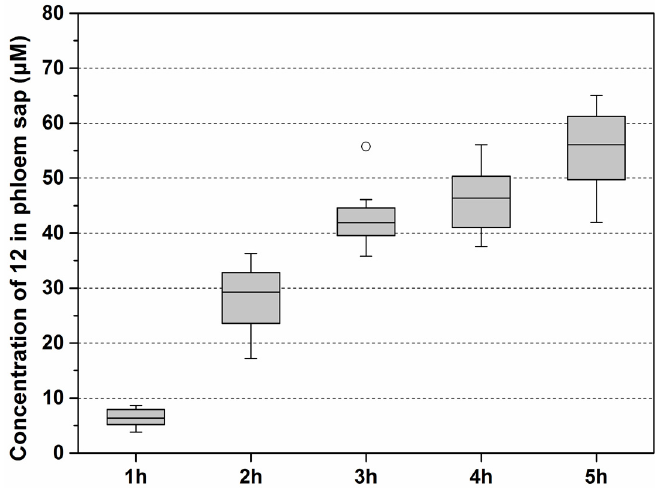
Figure 3. Time course of conjugate 12 concentration in phloem sap of R. communis. The cotyledons were incubated in a buffered solution containing 200 µM 12 at pH 5.5. The hook was severed at time 1 h, and then the sap was collected every 1 h during 5 h. For box plots, n = 8.